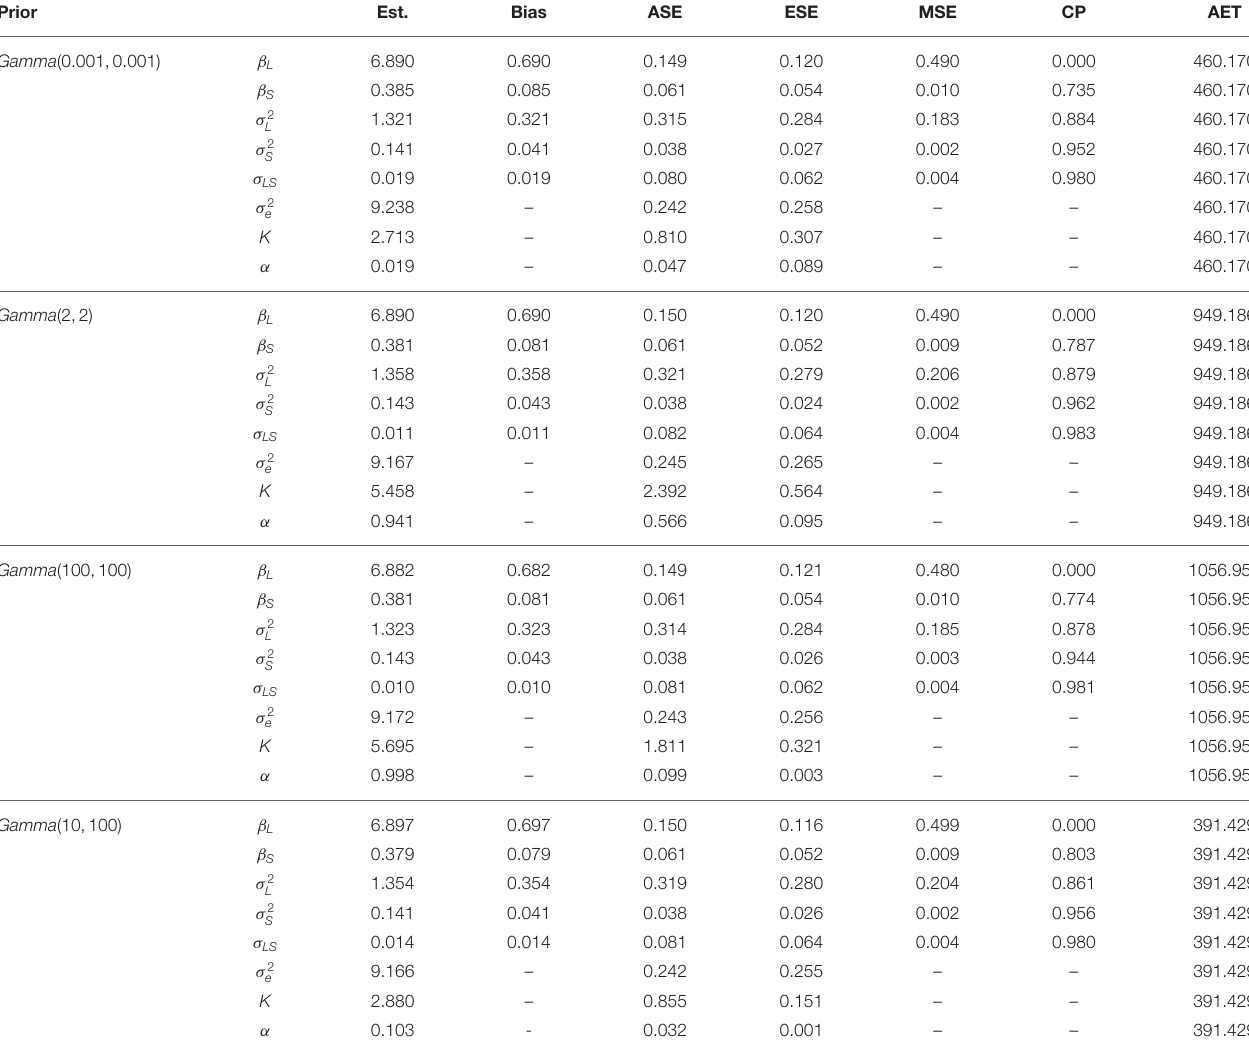
TABLE 5 | Model estimation for BNP growth curve modeling with different precision parameter priors when data contain 20% of outliers and N = 200. Prior Est. Bias ASE ESE Gamma